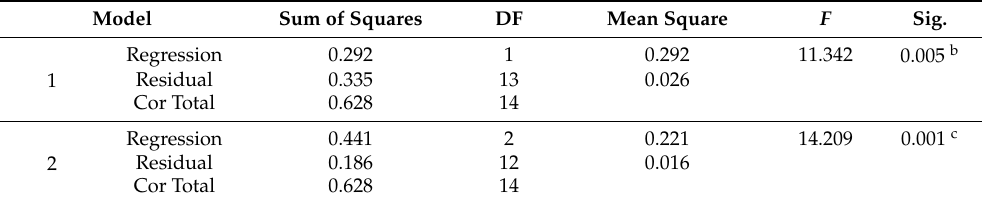
Table 6. ANOVA analysis of yield of HCPS.